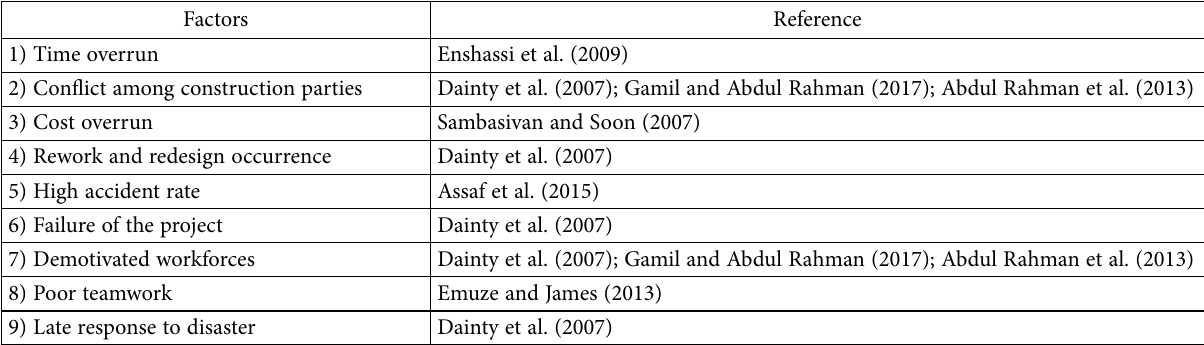
Table 2. Sources of effect factors of poor